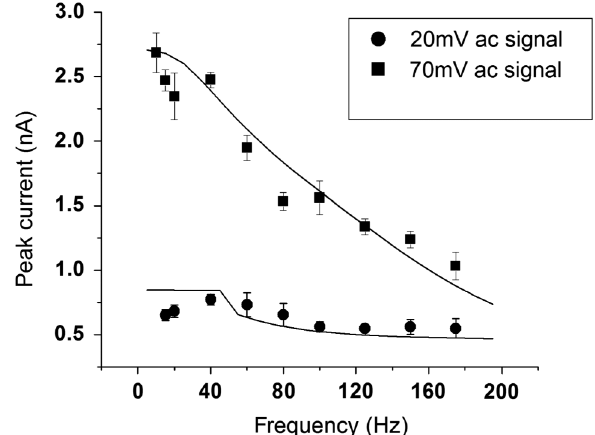
FIG. 11. The peak current measured as in Fig. 8 for (cid:3) ¼ FIG. 13. The dependence of the peak current (positive swing) 40 Hz . At this frequency, the two current branches are approxi- . The solid lines represent on the driving frequency for 20- and 70-mV rms amplitudes of mately symmetric and still linear in V 0 the model with identical parameter values to those in Fig. 8 the driving signal. The error bars show 1 standard deviation, and except for the excitation frequency (cid:3) . the lines represent the model described in the